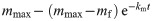
Mineralisation kinetics.Experimental mineralisation kinetics from Ref. [47] (dashed) together with two exponential fits of the form mmax-(mmax-mf)e-kmt (solid lines). The short-time fit has mf = 3 Ca wt%, mmax = 20.1 Ca wt%, km = 0.0194/day (also shown in the inset). The long-time fit has mf = 21.85 Ca wt%, mmax = 30.4 Ca wt%, km = 9.3 · 10-5/day.